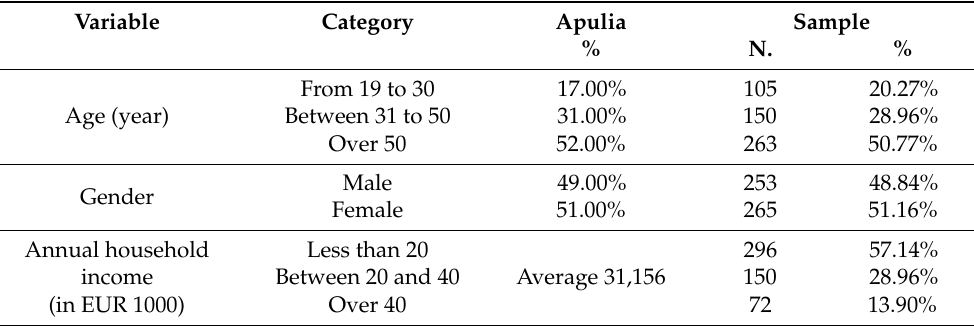
Table 4. Sampling of the respondents taking into consideration the age, gender and household income of the population in